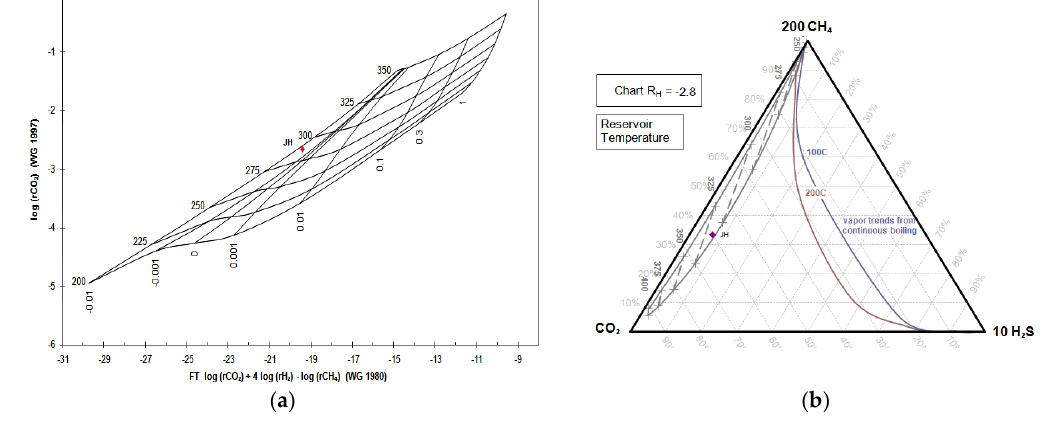
Figure 4. ( a ) FT-CO 2 cross-plot diagram and ( b ) CH 4 -CO 2 -H 2 S triangle diagram.